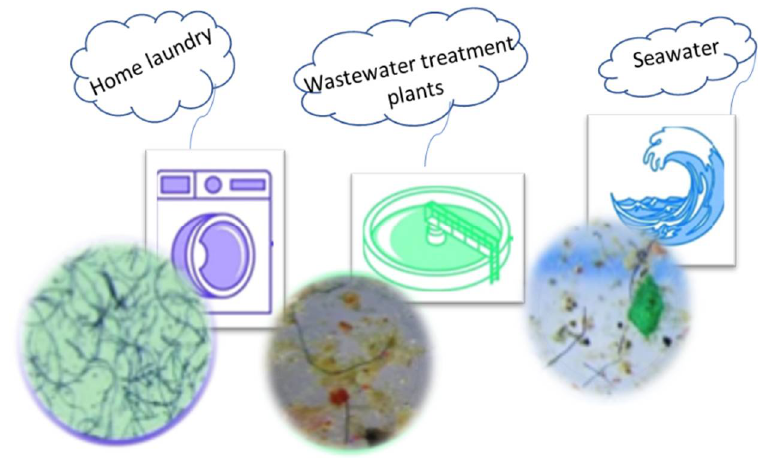
Figure 1. Microfibres detected in laundry effluent, wastewater and seawater [5].